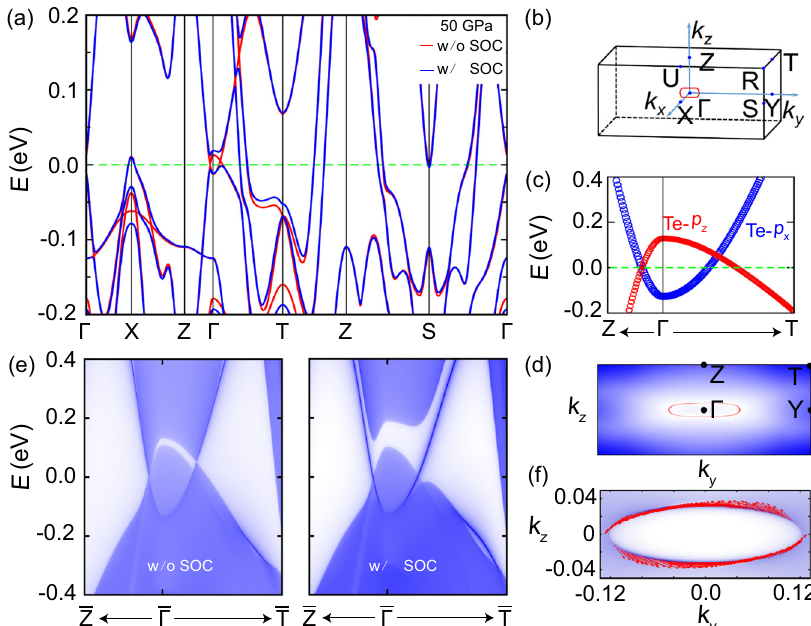
Fig. 5 Band structure calculations for AuTe 2 Br at 50 GPa. a Calculated band structure of AuTe 2 Br at 50 GPa. The red and blue lines represent the results without and with SOC. b The 3D bulk Brillouin zone (BZ). c Orbital-projected band structure near the Γ point. The contour of the nodal ring in the absence of SOC is shown by the red line in ( d ). The background color represents the magnitude of the gap between the Te p x and Te p z bands. With the gap increasing, the color changes from white to blue. Red ellipse highlights the zero gap. e Surface band structures without and with SOC for the (100) surface. f Fermi surface and corresponding spin texture at a fi xed energy E – E F = 20 meV of the topological surface states in the presence of